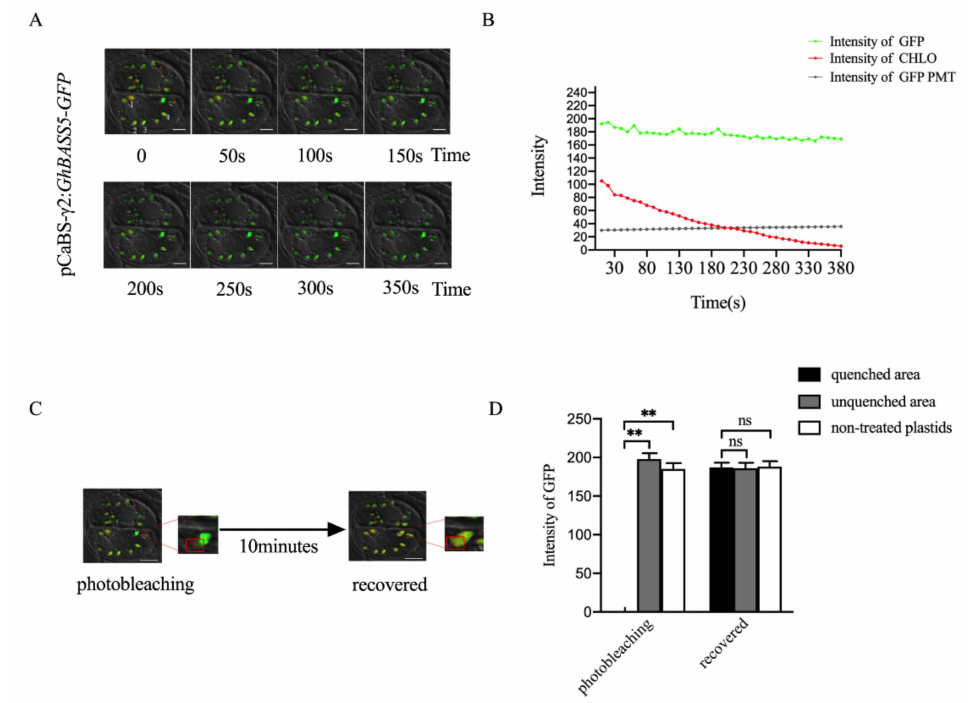
Figure 3. BSMV-mediated stable expression of recombinant protein in cotton. ( A ) Time series of GhBASS5-GFP in cotton leaf cells; ( B ) Comparison of the fluorescence intensity of GFP, CHLO, and PMT in the time series; ( C ) Photobleaching experiments, where the red box indicates the quenched area; ( D ) The GFP fluorescence intensity of the treated plastids and non-treated plastids. ** denotes a significant difference at p < 0.01 while ns indicates no significant difference, based on a two-tailed Student’s t